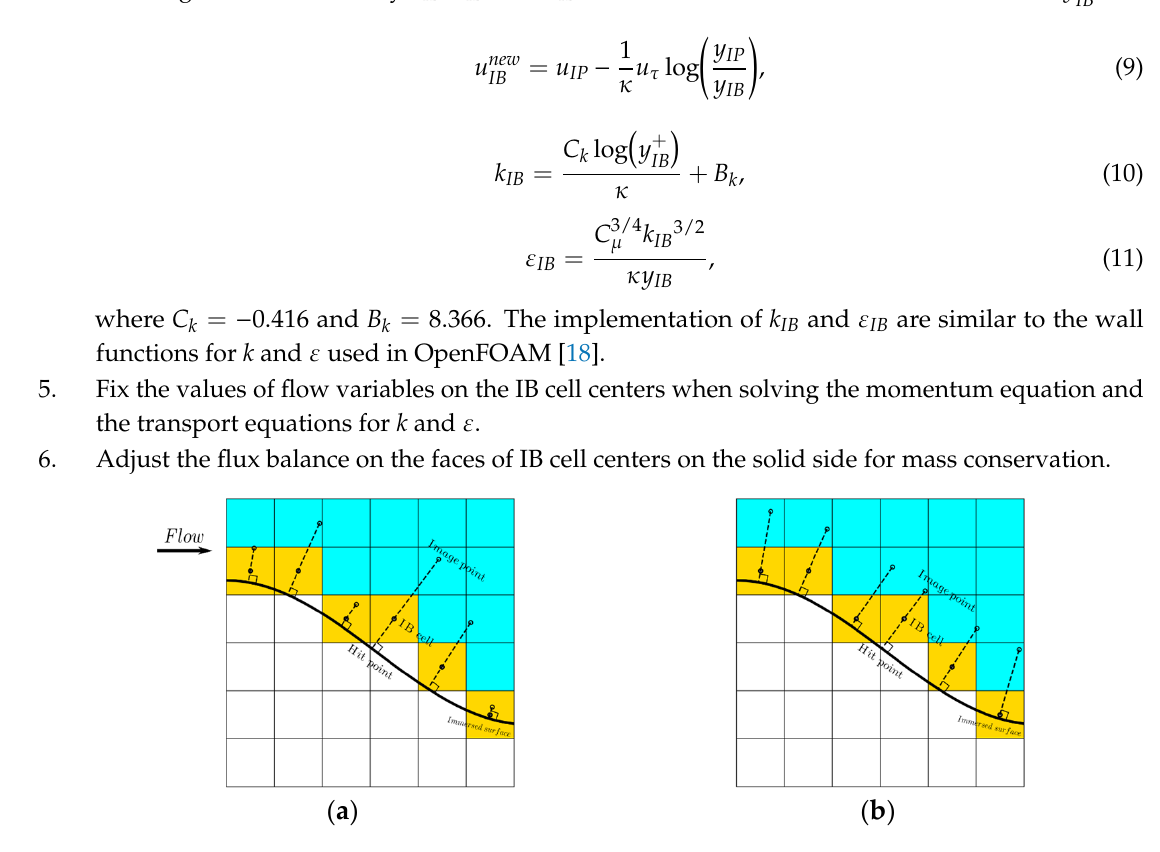
Figure 1. A schematic illustrating the IB models using a two-dimensional (2D) mesh. ( a ) y IP = 3 y IB ; ( b ) y IP = 3 l ∗